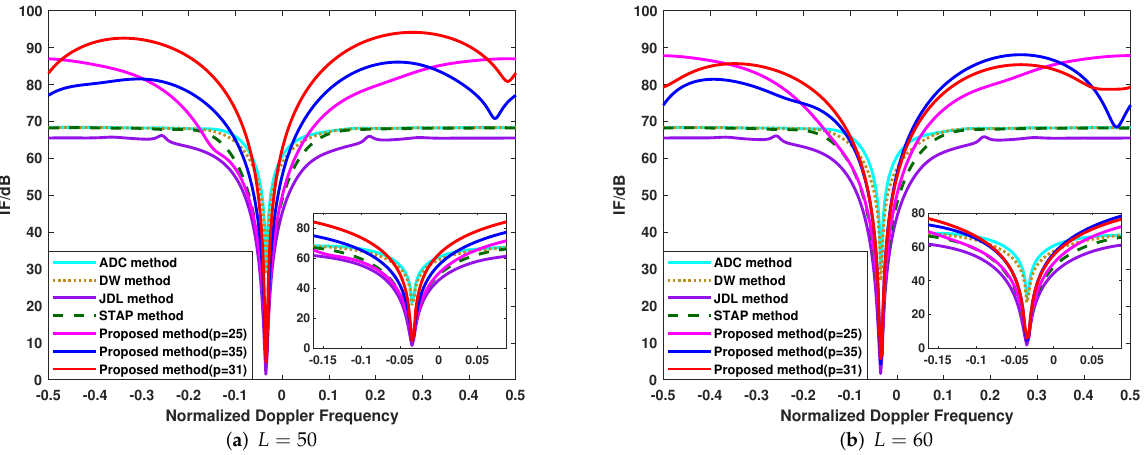
Figure 7. IF versus normalized Doppler frequency for CNR = 50 dB. ( a ) The number of training samples is L = 50. ( b ) The number of training samples is L =